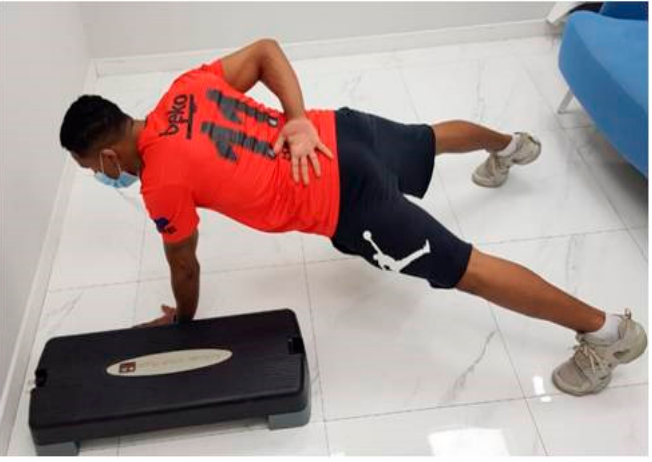
Figure 3. Starting position of the one-arm hop test.